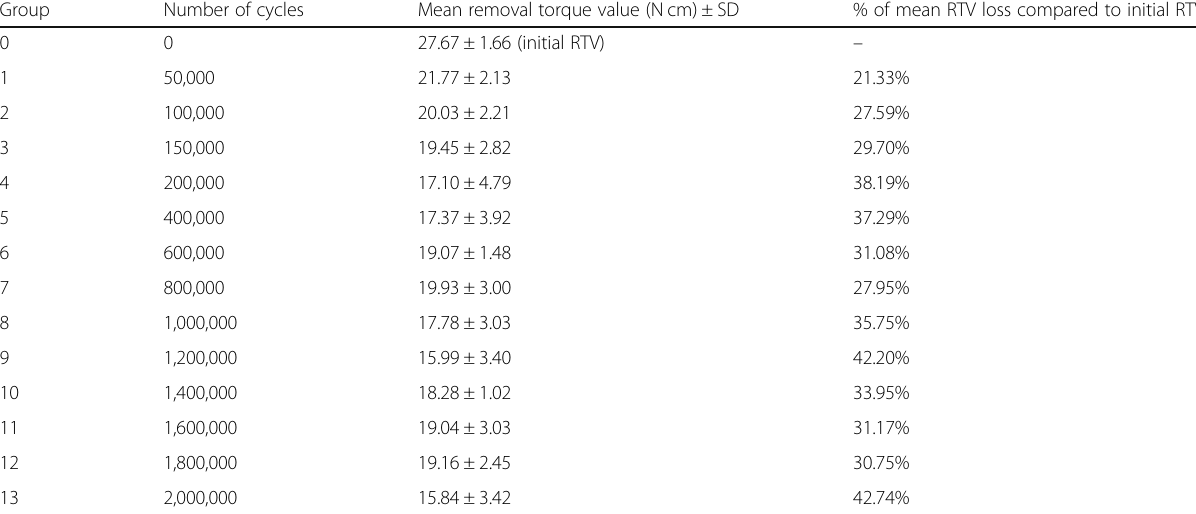
Table 1 Mean removal torque values (N cm) of the abutment screws of the implant-abutment connections in all groups Group Number of